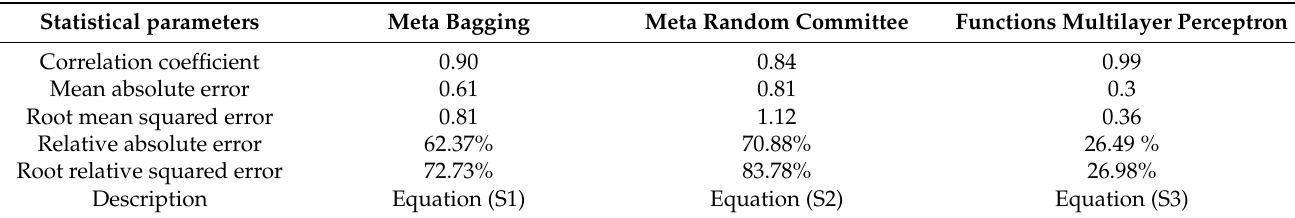
Table 5. The outputs of AI computations in the present research.